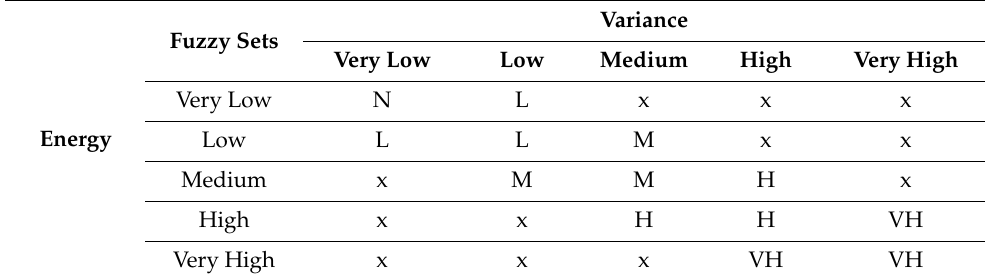
Table 4. Fuzzy Associative Matrix (FAM) table for energy vs. variance